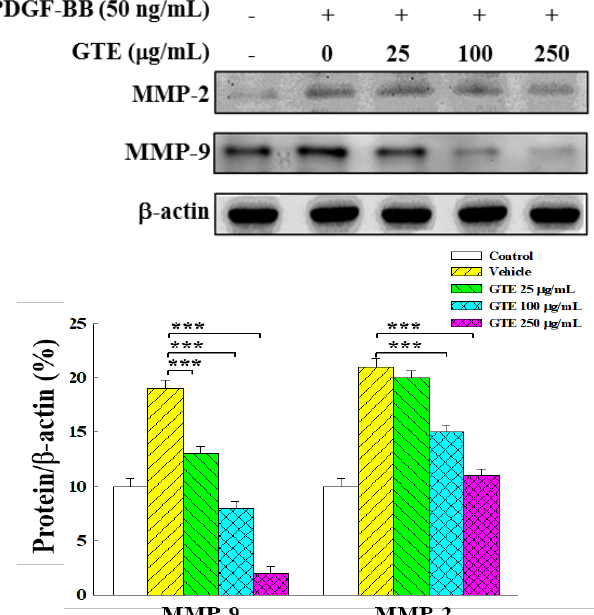
Figure 5. Effects of GTE on matrix metalloproteinase (MMP)-2 and MMP-9 expressions in PDGF-BB-stimulated VSMCs. Expressions of MMP-2 and MMP-9 were analyzed by Western blotting. PDGF-BB-stimulated VSMCs were treated with 0–250 μg/mL of GTE for 48 h. Data were estimated from triplicate experiments. A significant difference compared with the vehicle (group 0) is denoted as *** p < 0.001.